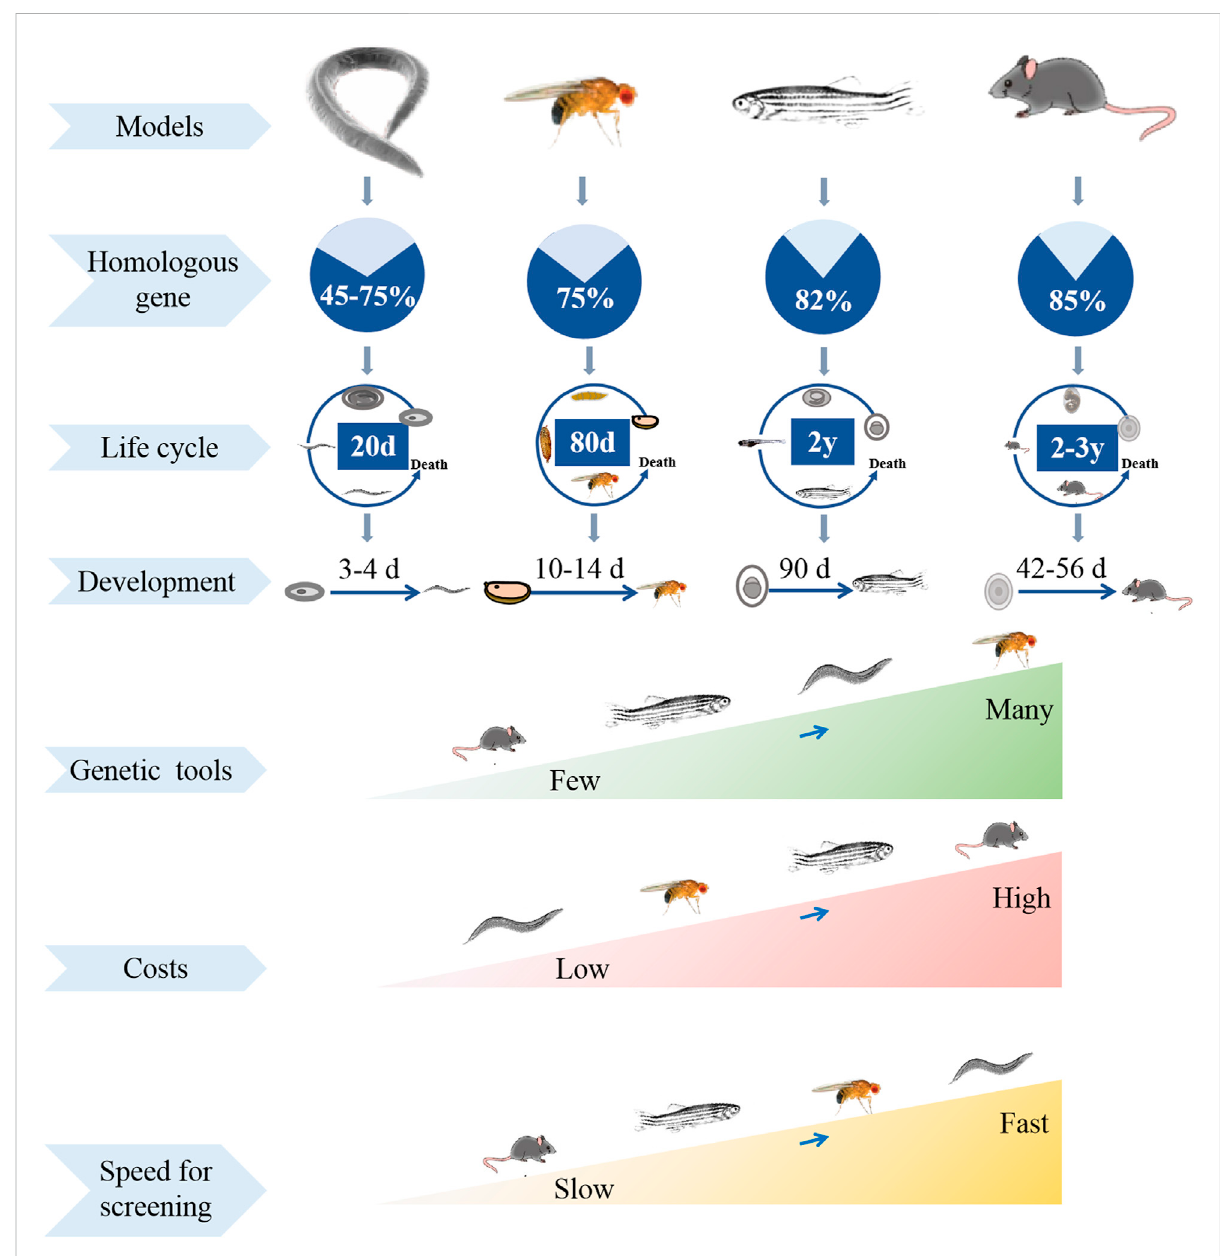
FIGURE 1 Comparison of experimental models in different species in multiple